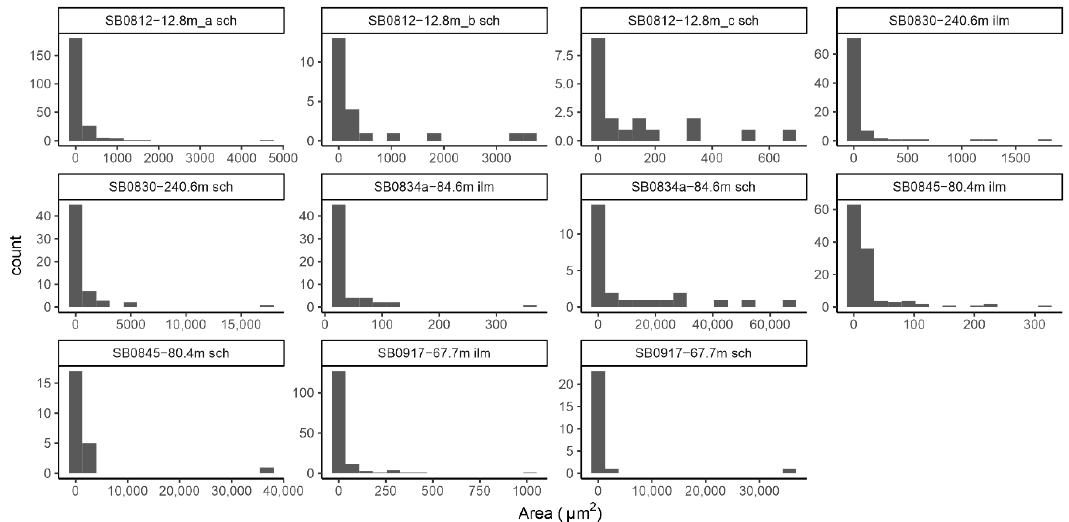
Figure 6. Histograms depicting populations of scheelite (sch) and ilmenite (ilm) grains for five samples.